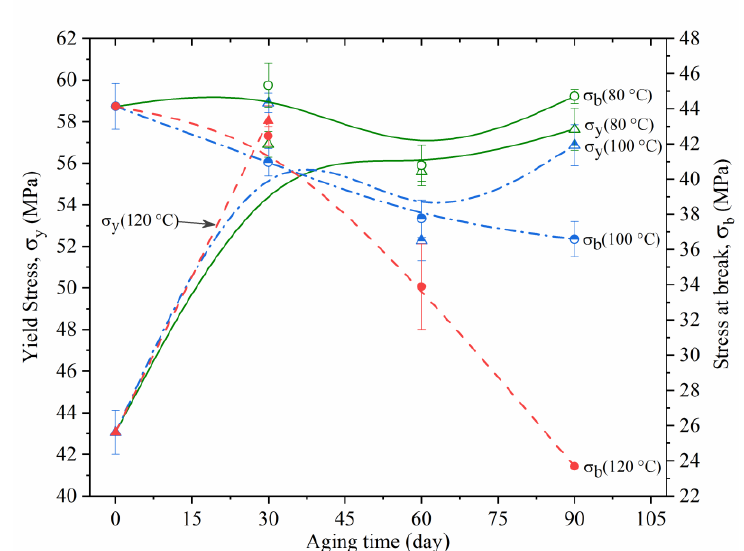
Fig. 3. Evolution of stress at yield and stress at break of (u-PVC) aged at (80, 100 and 120 °C) versus aging time.